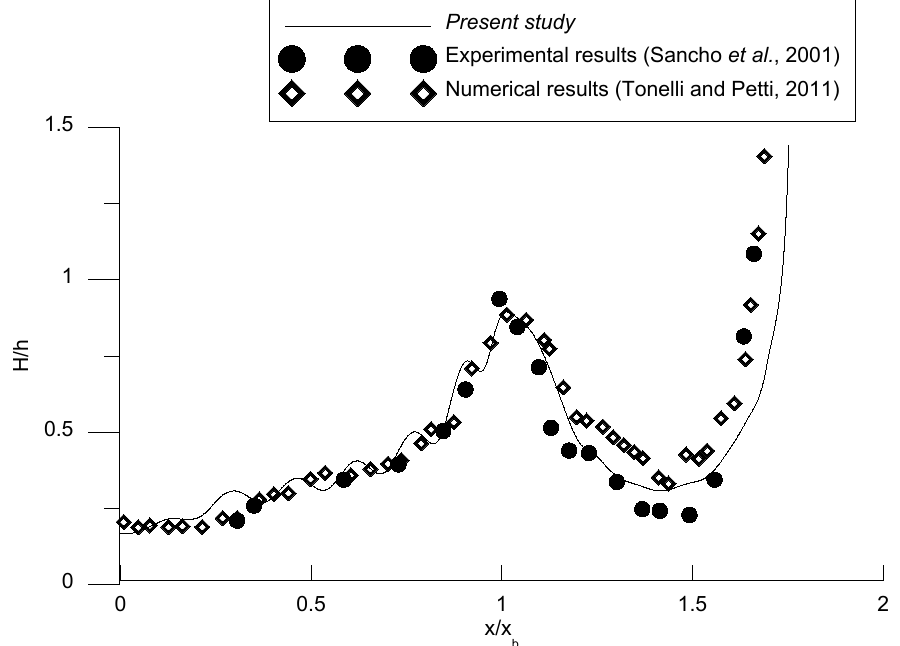
Figure 20. Comparisons of wave heights for breaking and dissipation of waves by a barred beach for the plunging breaking case [46,47].